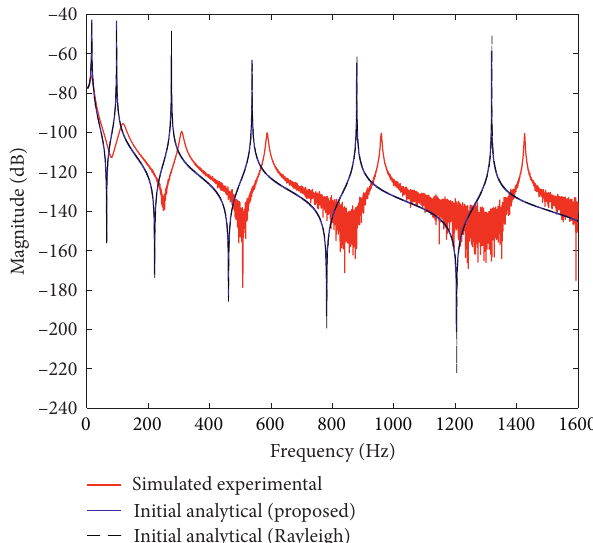
Figure 2: Comparison of simulated and initial analytical FRFs H